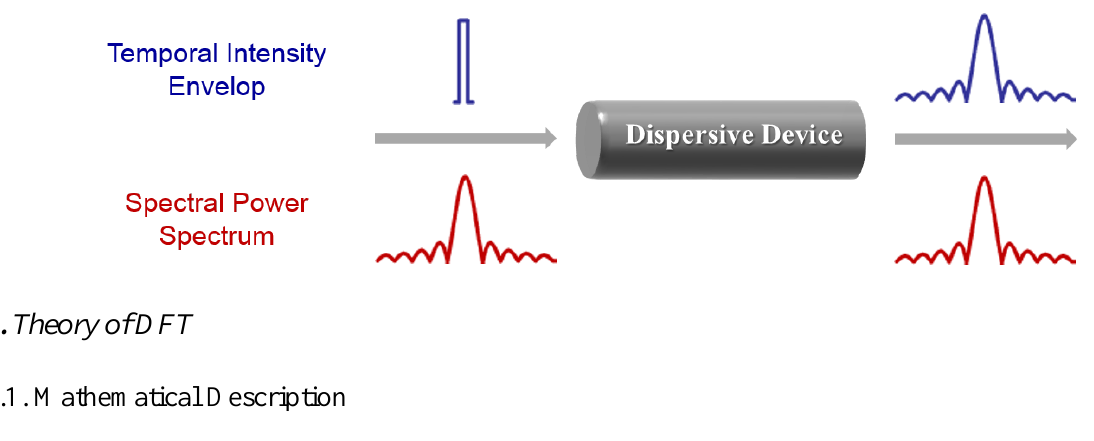
Figure 1. Schematic diagram illustrating dispersive Fourier transformation process in a dispersive